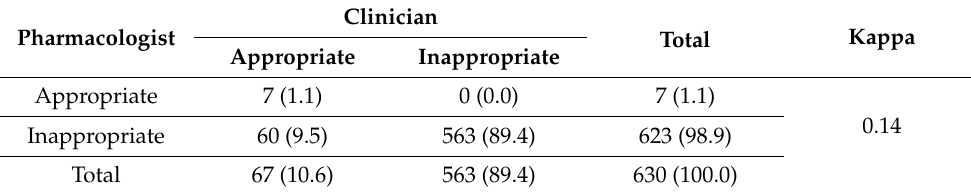
Table 4. Appropriateness of prescriptions according to clinician and pharmacologist.